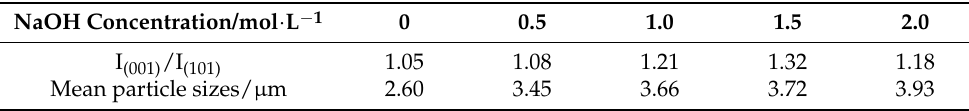
Figure 2. XRD patterns of different MH powders. Table 3. I (001) /I (101) and mean particle sizes of MH powders. Table 3. I (001) /I (101) and mean particle sizes of MH